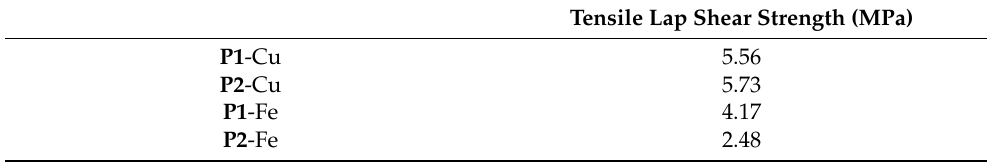
Figure 4. Adhesive properties of P1 and P2 hot pressed at 200 ◦ C for one hour between copper (Cu) and iron (Fe) plates. Table 2. Tensile lap shear strengths (MPa) of P1 and P2 hot pressed at 200 ◦ C for one hour according to JIS K